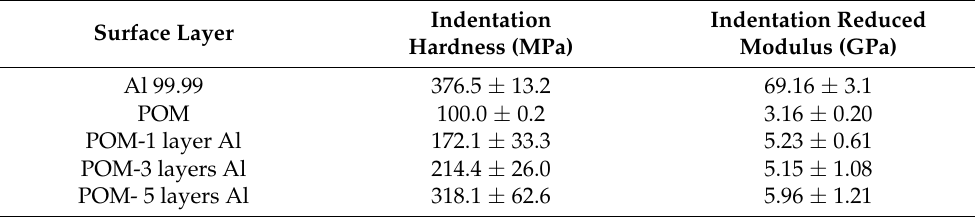
Table 4. Indentation hardness and modulus in the range between 1 and 5